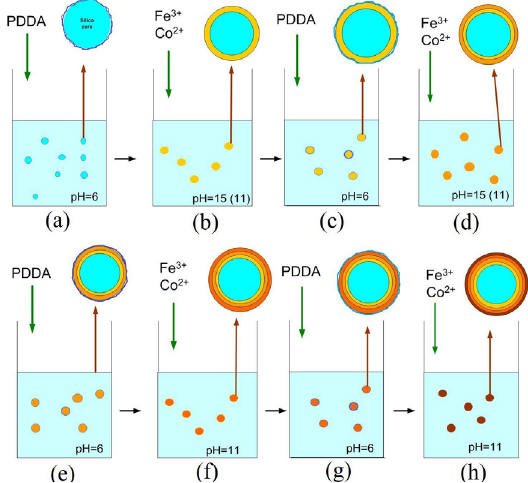
Figure 1. Preparation scheme of the bilayered silica/ferrite core- shell particles prepared at pH value of 15 (sample CF2-15) and 11 (sample CF4-11), followed by PDDA functionalization at